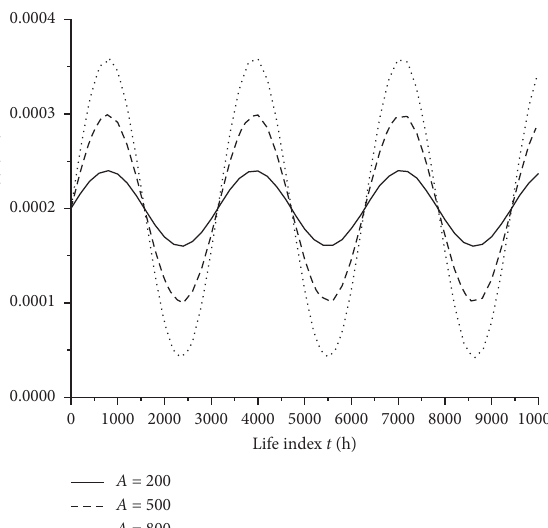
Figure 15: Effects of oscillation amplitude on failure rate.